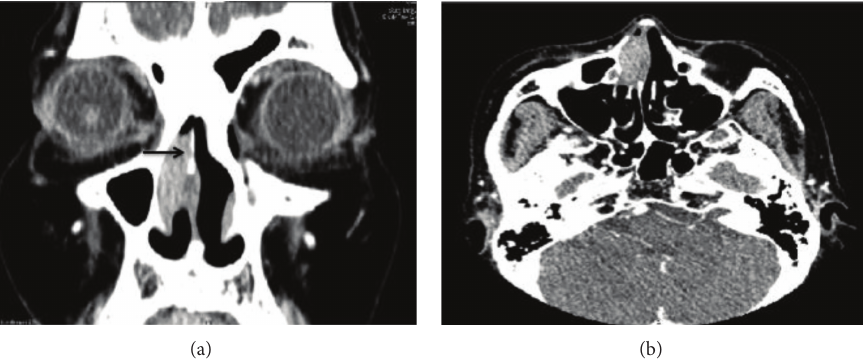
Figure 1: Coronal (a) and axial (b) images of paranasal sinus computed tomography. The mass is heterogeneously iso-intense between the nasal septum and lateral nasal wall, with erosion of septal bone (arrow).